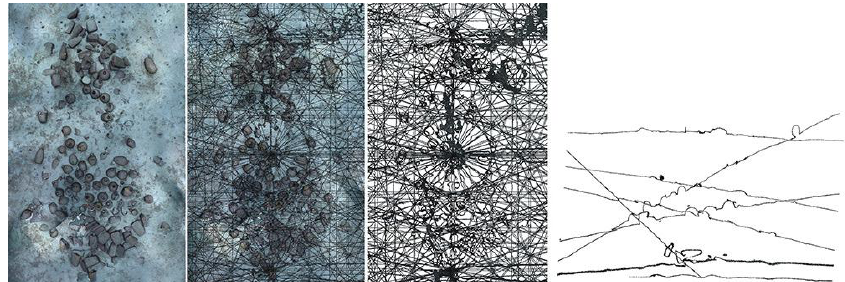
Figure 16. On the left, the ground 3D model computed by photogrammetry, on the right, level curves extraction from several planes with partial trace of the amphorae and other artefacts.